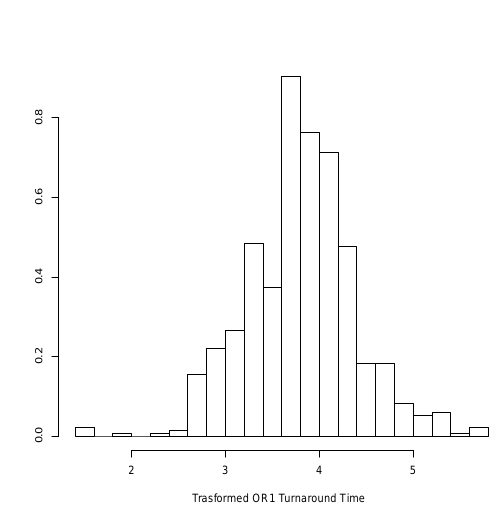
Figure 3 – Histogram of transformed data for OR 1 TaT